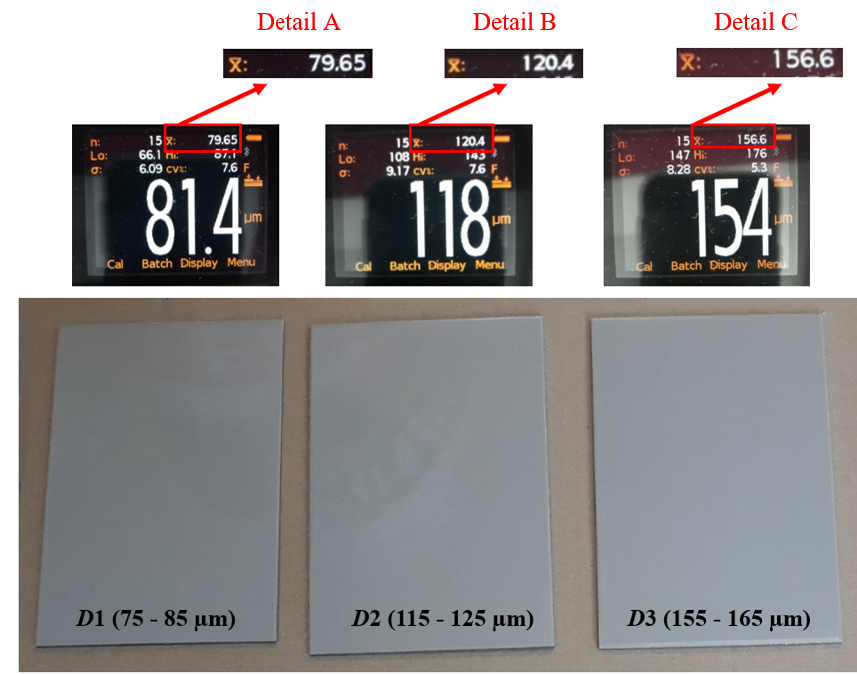
Figure 3. Test specimens after coating.